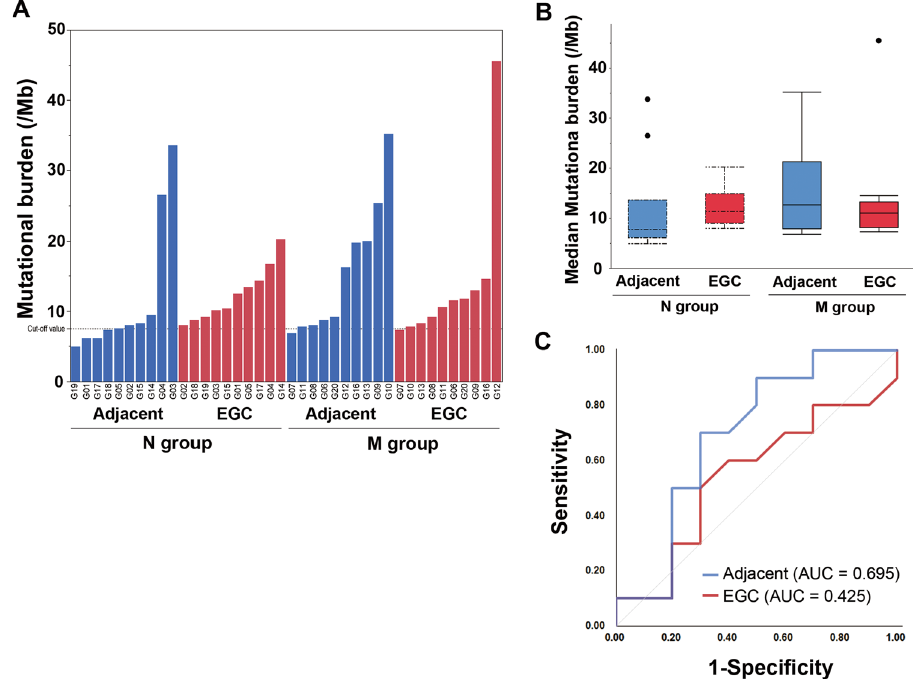
Figure 4. Mutational burden. MBs ( A , B ) tended to be higher in the M group [12.6 (7.9–21.3), in the adjacent non-cancerous mucosa, and 11.0 (8.1–13.3) in the initial EGC] than in the N group [7.7 (6.1–13.6) in the adjacent non-cancerous mucosa, 11.3 (9.0–14.9) in the initial EGC]. ROC analysis ( C ) showing that the AUC value of the MB in the adjacent, non-cancerous mucosa is higher than that in the initial EGC, and confirms 7.75 as the cutoff value for predicting metachronous developments. Box plot: the bottom and top of each box represent the 25th and 75th percentiles, respectively, and the band in the box is the median. Whiskers: the lowest datum is within the minimum, and the highest datum is still within the 1.5 IQR of the upper quartile. Values of outliers are drawn as dots. MB mutational burden, EGC early gastric cancer, ROC receiver operating characteristic, AUC area under the curve, IQR interquartile range.